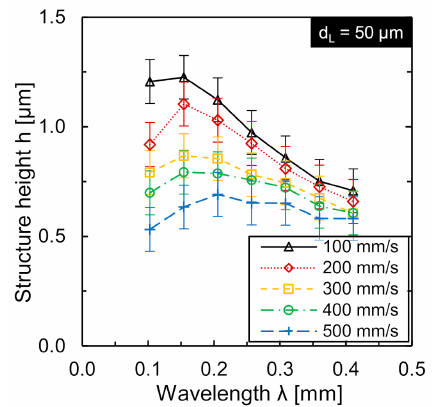
Figure 7. Structure height h as function of normalized wavelength for five different scan speeds v scan ( d L = 50 µ m, P A and P M linearly adapted to v scan ).